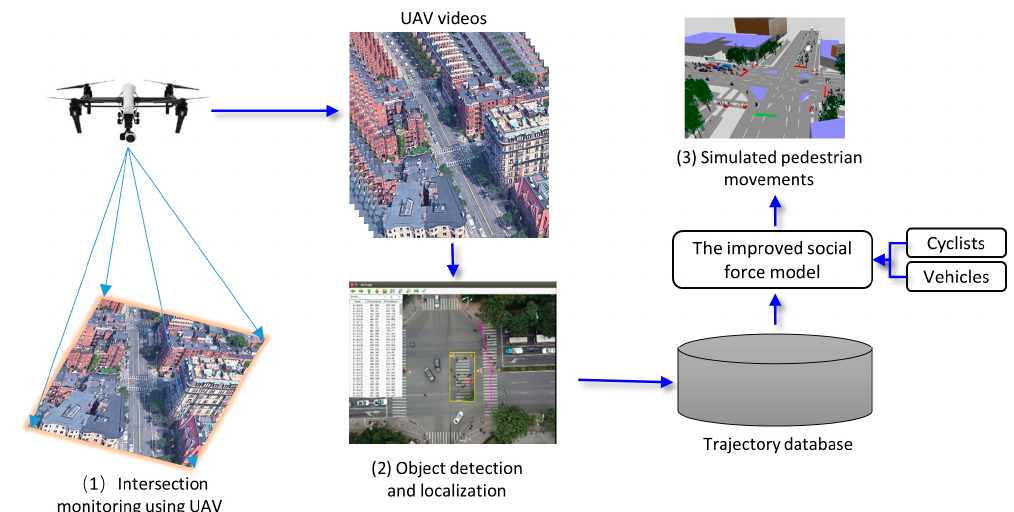
Figure 1. Workflow of tracking and simulating pedestrian movements at intersections using an unmanned aerial vehicle.